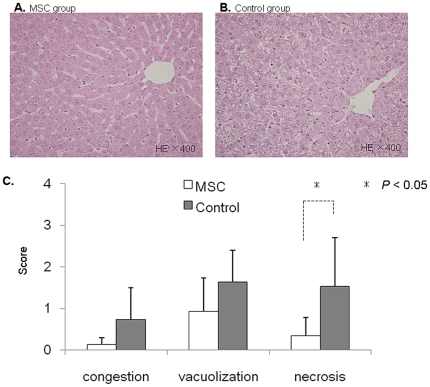
Histopathological changes and Suzuki Score.Hematoxylin eosin staining of I/R-injured liver sections from the MSC group (A. left panel) and the Control group (B. right panel). C. The lower levels of congestion, vacuolization, and necrosis were seen in the MSC group. Suzuki scores = (MSC group vs. Control group: 1.4±1.3 vs. 3.9±1.7, p<0.03).